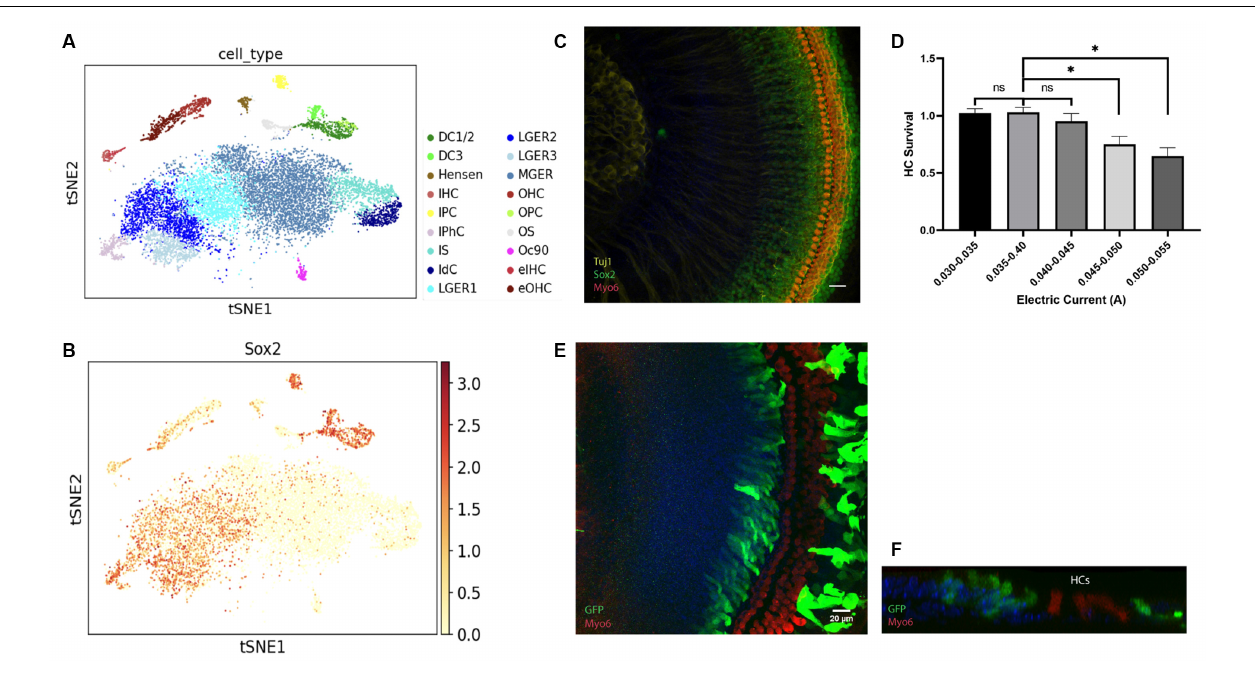
FIGURE 1 | (A–C) Identification of Sox2+ cells in the cochlea from the neonatal mouse. (A–B) tSNE plot for ∼ 14,000 cochlear cells collected from P1 mice. (A) Distinct cell types within the cochlea are labeled with different colors. (B) Feature plots showing the expression of Sox2 for the same cells in (A) . Expression is concentrated in the IPC, DC, lateral GER with a low expression level in HCs. (C) Localization of expression for Sox2 in P0.5 cochlear explants. HCs are labeled with Myosin6 and spiral ganglion neurons are labeled with Tuj1. (D–F) The high efficiency of gene delivery to the lateral GER is mediated by electroporation. (D) HC survival rate in explants applied with different electric currents. (E) The HCs are intact and barely electroporated, GFP+ cells indicated transfected cells located in the lateral GER and lesser epithelial ridge (LER). (F) A representative orthogonal image showing the transfected GFP+ epithelium cells. Scale bars: 20 µ m. * P < 0.05 and ns, not significant by unpaired two-tailed Student’s t -test. Results are presented as the mean ± SEM.